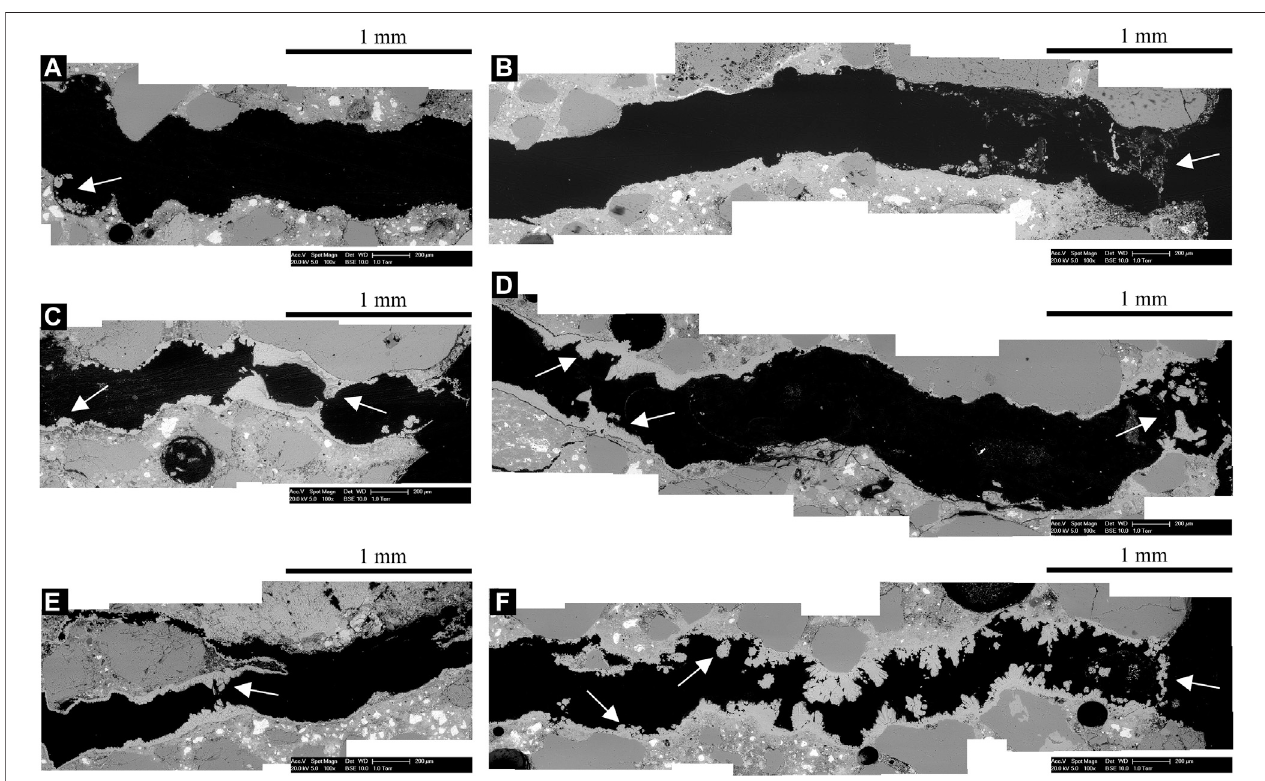
FIGURE 7 | Polished sections perpendicular to the crack under ESEM/BSE of (A,B) Ctrl-28d plain mortar, (C,D) PLA-28d and (E,F) AKD-28d specimens (precipitates are indicated by white arrows). B , D and F are representative for the crack mouth of each specimen. A , C and E are micrographs taken at around 20 mm depth perpendicularly to the